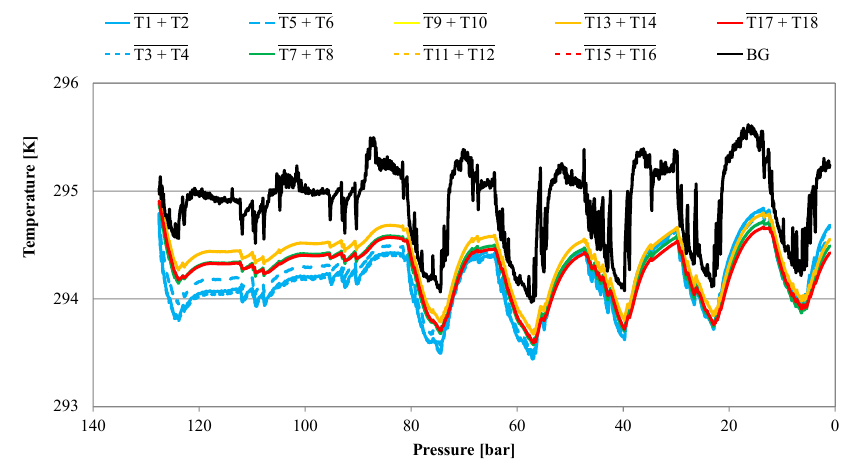
Figure 7. Temperature development of CB11795 during the low-flow measurement with horizontally positioned cylinders as a function of pressure; note the inverse pressure scale. The lines represent averages of the following thermistors. Pressure regulator to stem: solid blue, T1 and T2; dotted blue, T3 and T4; dashed blue, T5 and T6. Cylinder valve: green, T7 and T8. Cylinder body: yellow, T9 and T10; dashed orange, T11 and T12; solid orange, T13 and T14; dashed red, T15 and T16; solid red, T17 and T18. Laboratory background: black, T19 to T25.